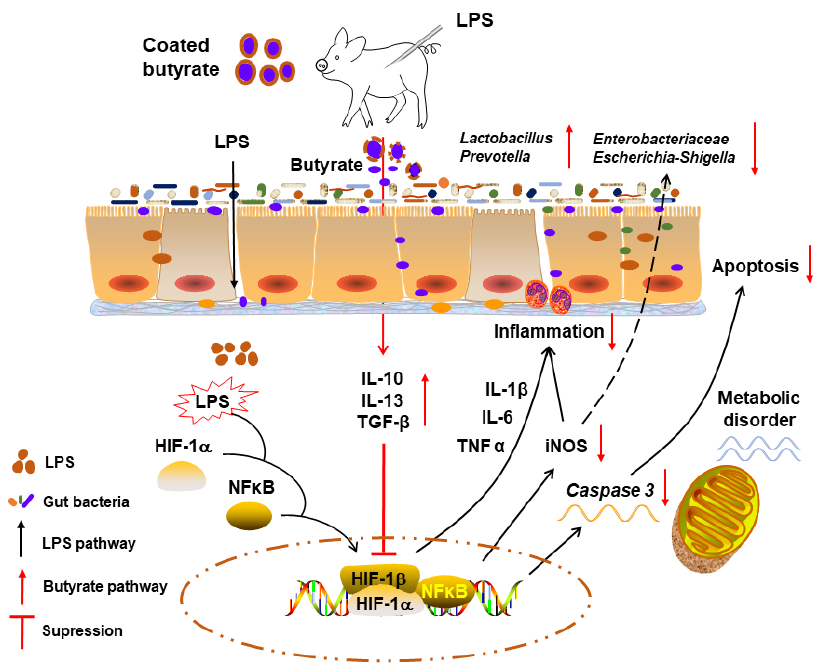
Figure 8. Schematic showing how butyrate putatively protects weanling piglets from LPS-induced intestinal histology changes by regulating microbiota and energy metabolism levels, as well as alleviating inflammation and apoptosis.